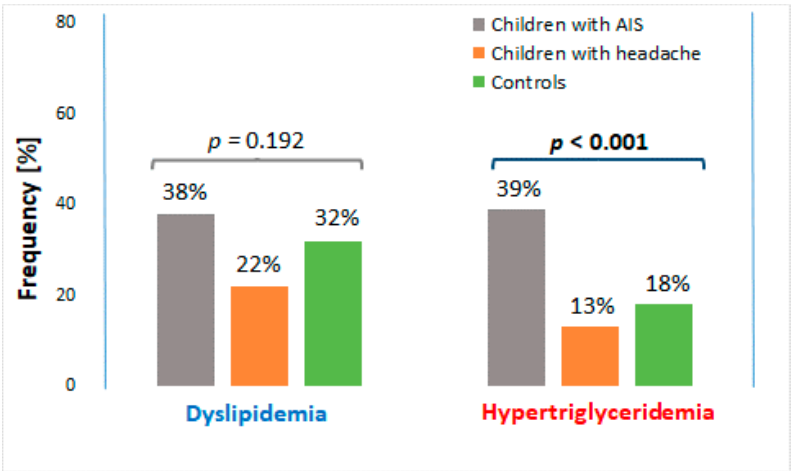
Figure 2. Prevalence of dyslipidemia and hypertriglyceridemia in all analyzed groups. AIS—arterial ischemic stroke. Significant difference is in bold.